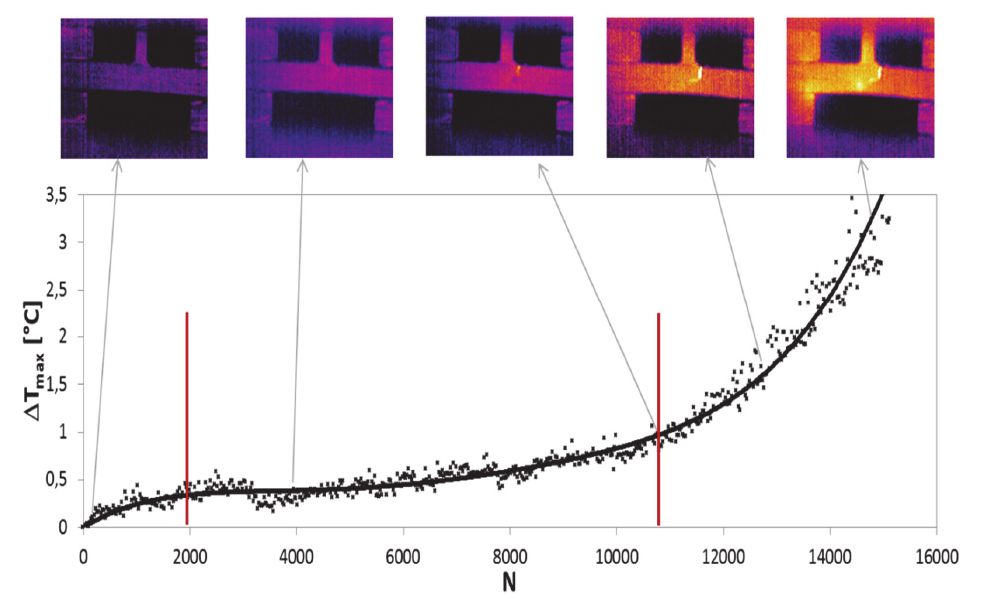
Figure 13:  -N curve during the test at P max = 20